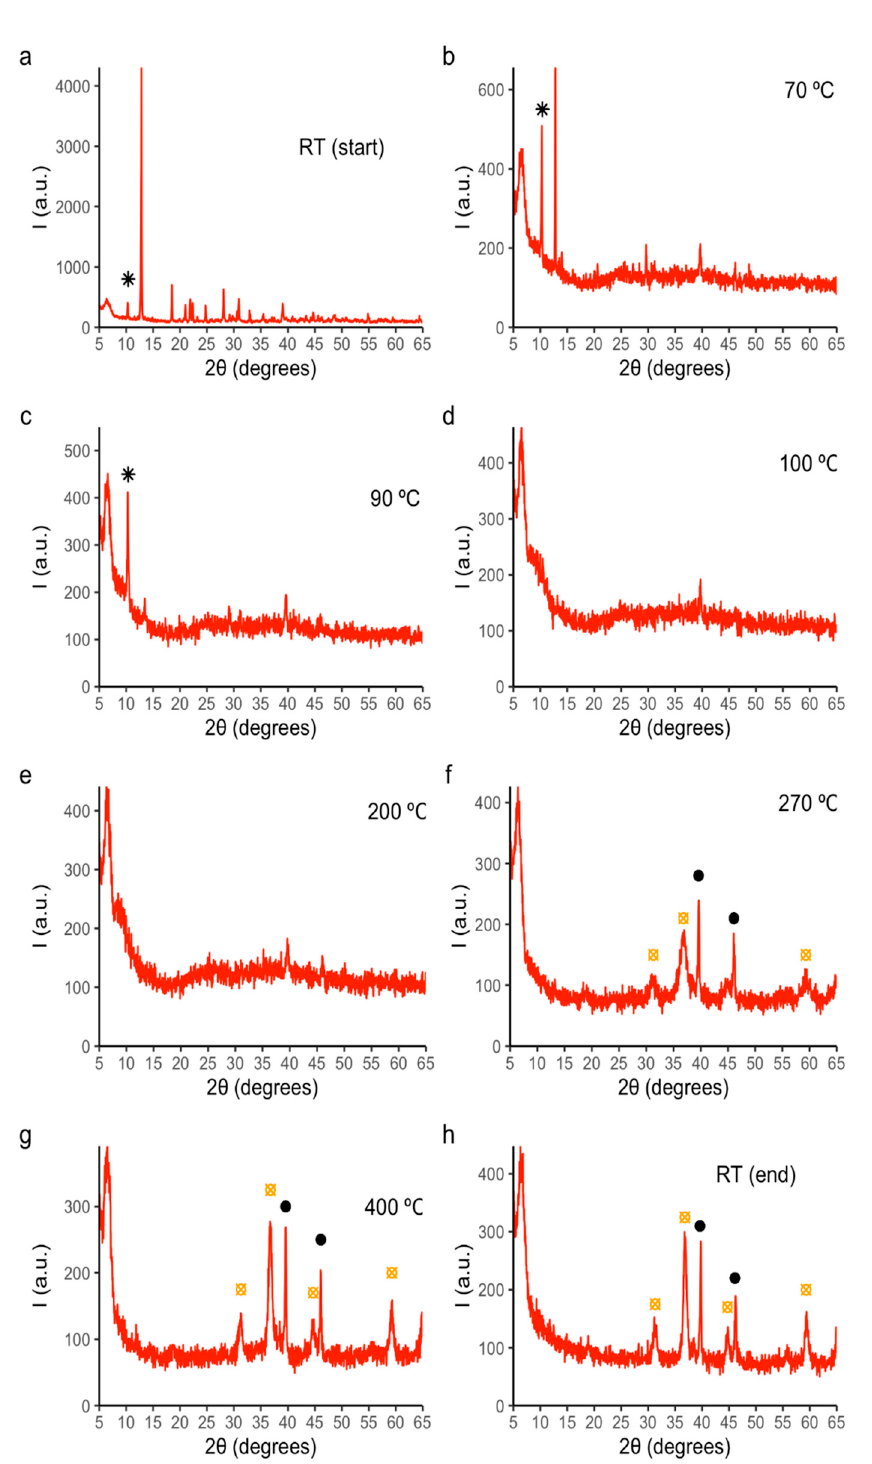
Figure 14. X-ray powder diffraction of cobalt acetate tetrahydrate heated under air atmosphere from RT to 400 ◦ C and afterward cooled down to RT. Selected temperature steps are shown in the heating process ( a – g ) together with the final scan back to RT ( h ). Main phase in the starting room temperature scan is cobalt acetate tetrahydrate (PDF-00-025-0372), but the dihydrate phase (PDF-00-022-1080) can also be observed as a minor phase (main peak marked with a black asterisk in ( a – c ) scans). Main peaks of present phases are marked in scans ( f – h ) as follows: black circle for platinum (PDF-01-087-0642) and orange crossed circle for Co 3 O 4 (PDF-01-086-8289).